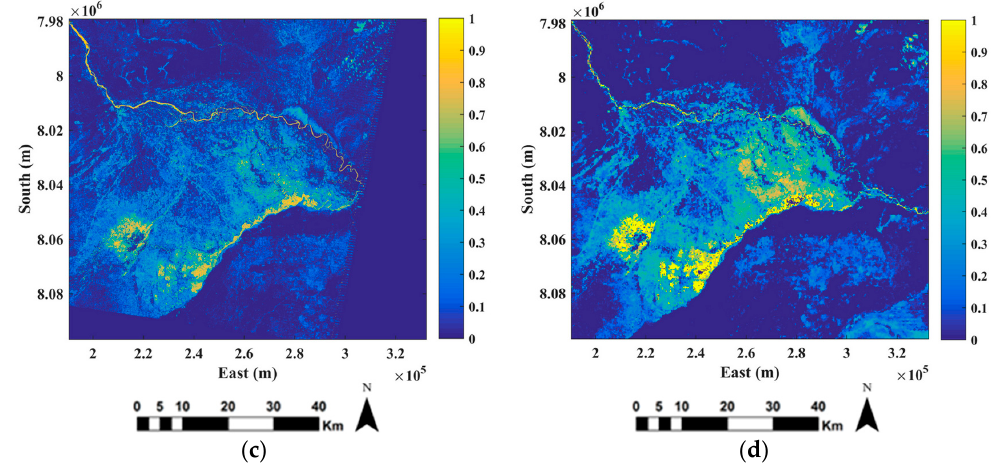
Figure 11. γ w calculated with the 17 April 2008 ( a ) TM and ( b ) MERIS images, compared to the γ w derived from the ( c ) 22 May 2009 and ( d ) 23 May 2009 MERIS images.